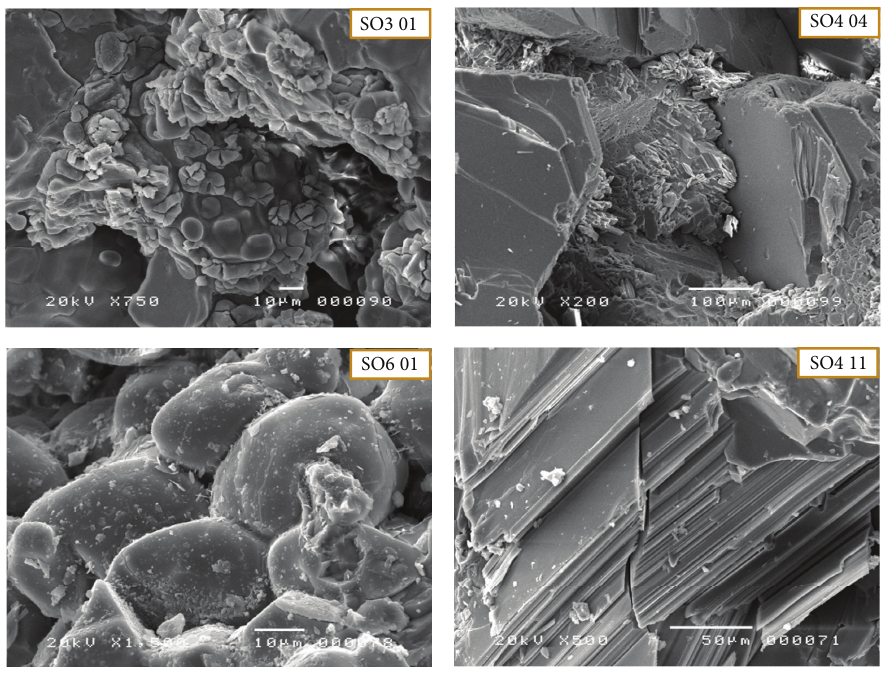
Figure 8: SEM images show some crystallization defects in the mineralogical phases of white cement clinker.